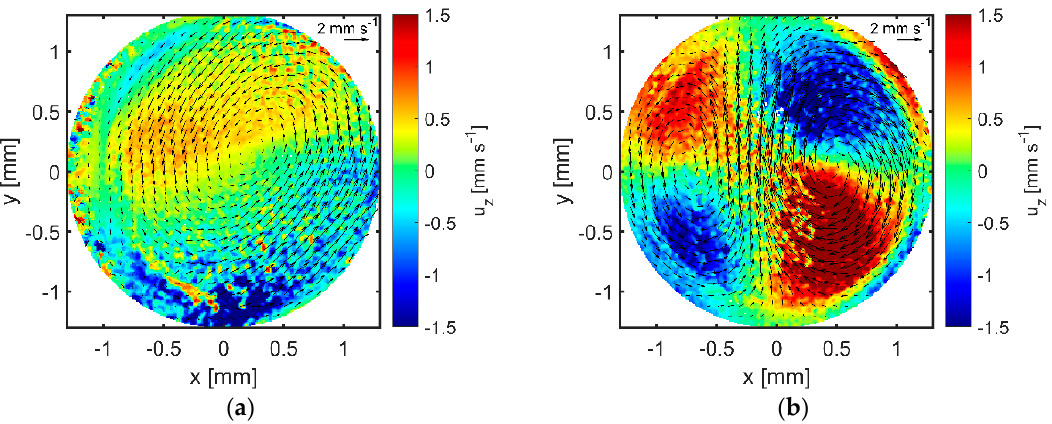
Figure 8. Typical single-vortex flow pattern obtained by µ PIV in a GB-MBR with S = 60 ◦ at P mix = 600 W · m − 3 and ( a ) f = 66 Hz and ( b ) f = 206 Hz. The abscise and the ordinate indicate lateral coordinates x and y within the GB-MBR. The origin (0,0) is the center of the GB-MBR. The arrows indicate magnitude and direction of the lateral flow vector u x , u y . The background color indicates magnitude and direction of u z .